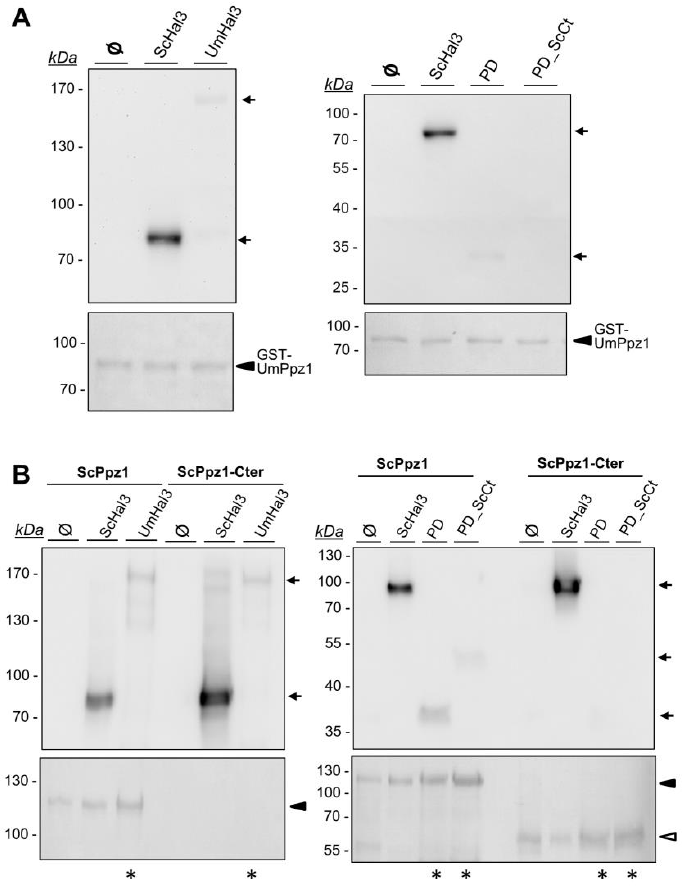
Figure5. EvaluationoftheinteractionbetweenUmHal3variantswithScPpz1andUmPpz1. Glutathione Figure 5. Evaluation of the interaction between UmHal3 variants with ScPpz1 and UmPpz1. beads containing 4 µ g of the GST-tagged UmPpz1 (panel A ) or 8 µ g of ScPpz1 and ScPpz1-Cter (panel B ) Glutathione beads containing 4  g of the GST-tagged UmPpz1 (panel A) or 8  g of ScPpz1 and were immobilized on glutathione beads and mixed with extracts from IM021 (ppz1 hal3) cells expressing ScPpz1-Cter (panel B) were immobilized on glutathione beads and mixed with extracts from IM021 3HA-tagged ScHal3, UmHal3, UmHal3_PD (PD) or UmHal3_PD_ScCter (PD_ScCt) from the pWS93 (ppz1 hal3) cells expressing 3HA-tagged ScHal3, UmHal3, UmHal3_PD (PD) or UmHal3_PD_ScCter plasmid. Beads were washed, resuspended in 100 µ L of 2x sample bu ff er and processed for SDS-PAGE (PD_ScCt) from the pWS93 plasmid. Beads were washed, resuspended in 100  l of 2x sample buffer (6% gels for UmHal3 and 10% for PD and PD_ScCter). Typically, 25 µ L of the samples was used, except and processed for SDS-PAGE (6% gels for UmHal3 and 10% for PD and PD_ScCter). Typically, 25  l in lanes marked with an asterisk, where 50 µ L was employed. Proteins were immunoblotted using of the samples was used, except in lanes marked with an asterisk, where 50  l was employed. Proteins anti-HA antibodies as described in Methods. Ponceau staining of the membranes is shown to evaluate were immunoblotted using anti-HA antibodies as described in Methods. Ponceau staining of the for correct loading and transfer (ScPpz1-Cter was not seen in the left blot in panel B because due to its membranes is shown to evaluate for correct loading and transfer (ScPpz1-Cter was not seen in the left relatively low molecular mass run with the front of the 6% blot in panel B because due to its relatively low molecular mass run with the front of the 6% gel).